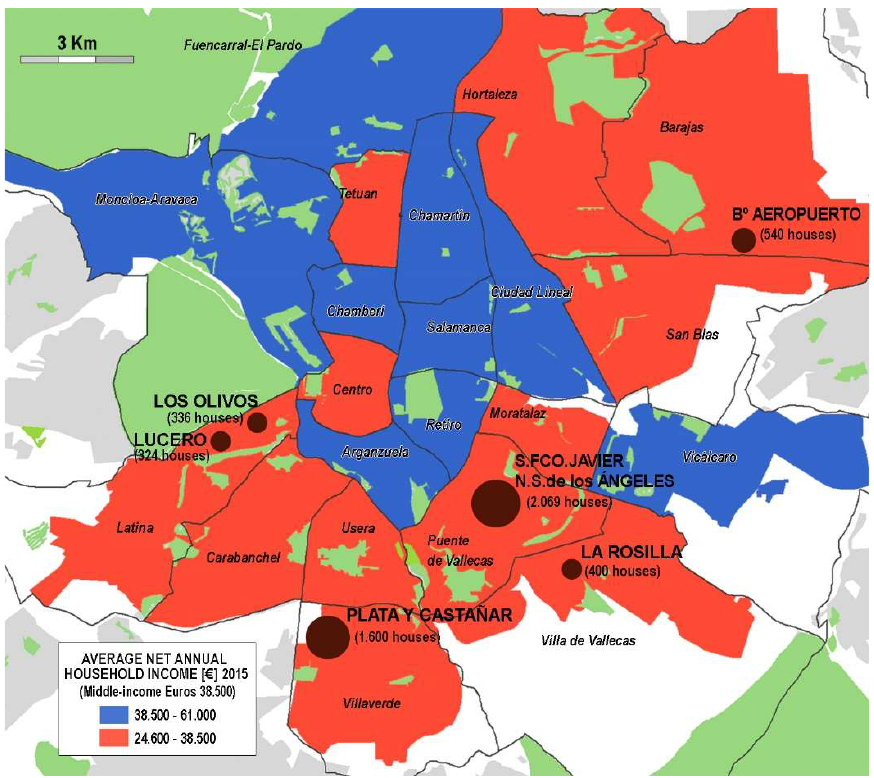
Figure 3. Location of the projected eco-neighborhoods in Madrid. The circles are proportional to the number of planned dwellings. Source: The authors based on Table 1 below and statistical data from Urban Indicators (European Urban Audit Project). Ayuntamiento de Madrid. Área de Información Estadística (Average net annual household income in Madrid. Sub-City District. 2015).